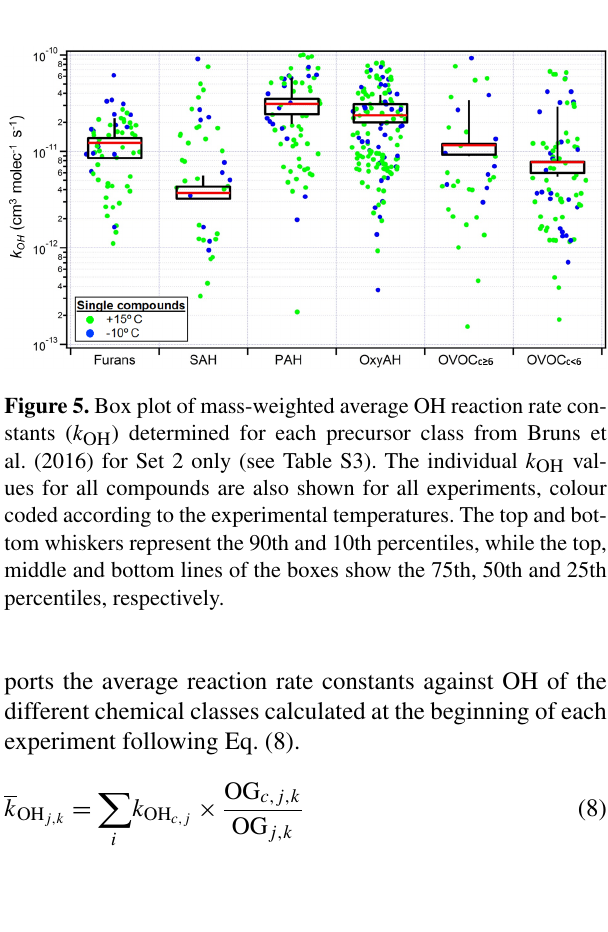
Figure 4. Average consumption of SOA precursor classes against average OH exposure for Set 1 (a) and Set 2 (b) . The observed decay of SOA precursor families (OGs) as described in Eq. (1) is due to both oxidation processes and dilution in the chamber. (c) SOA-to-POA ratio for each experiment against average OH exposure coloured according to experimental temperatures (2, − 10, 15 ◦ C).